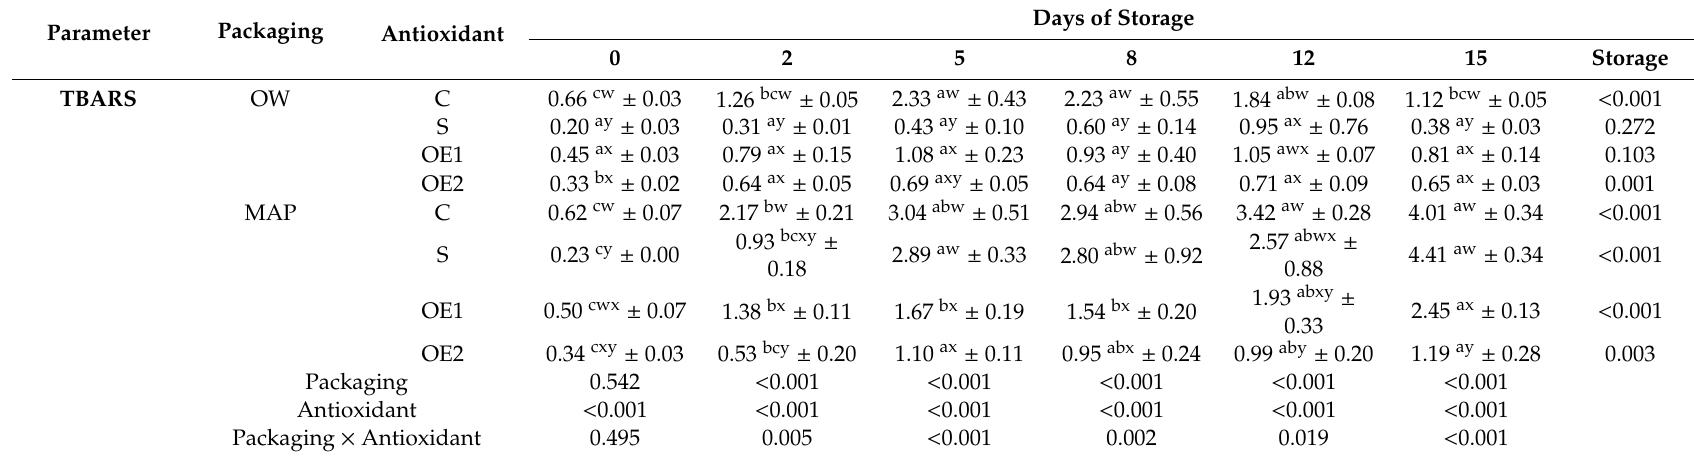
Table 7. Evolution of the TBARS (mg MDA / Kg) values (mean values ± standard deviations) of beef patties with di ff erent formulations α packed under di ff erent conditions β during storage at 4 ◦